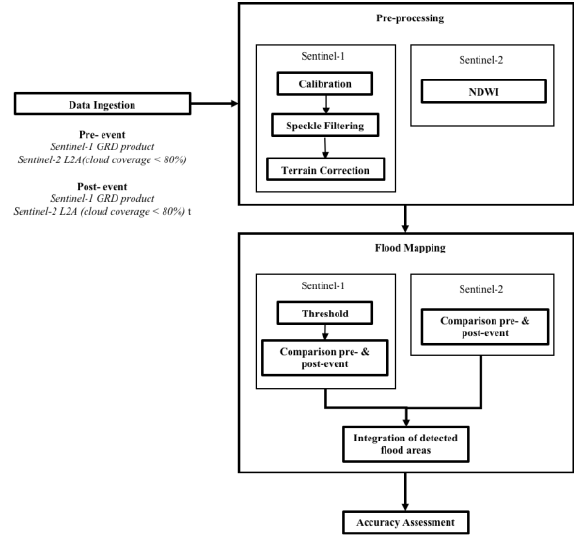
Figure 1. Flowchart of the proposed flood mapping processing